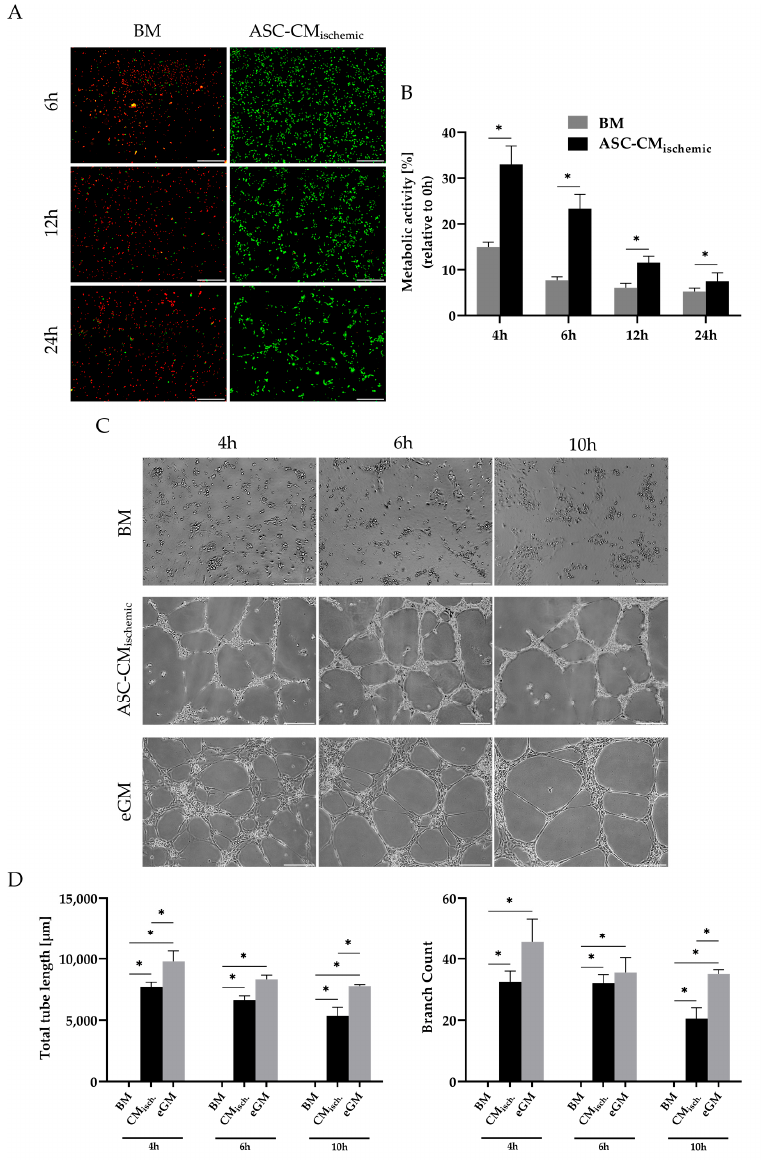
Figure 7. Effect of conditioned medium of glucose/oxygen-deprived ASCs (CM ischemic ) on viability and angiogenesis of human umbilical vein endothelial cells (HUVECs). ( A ) Live/dead staining at different time points. Viable cells were stained with calcein (green) and dead cells were stained with ethidium bromide (red) at different time points. Scale bar represents 500 μ m. ( B ) Determination of metabolic activity by a MTT assay; % metabolic activity was calculated in relation to the mean value of day 0. ( C ) Tube formation by HUVECs in basal medium, ASC-CM ischemic and endothelial growth medium on growth factor-reduced matrigel. Representative micrographs were shown at di ff erent time points (4, 6, and 10 h) for illustration of tube formation. Scale bar represents 200 µ m. ( D ) Total tube length (left column) and the number of branch points (right column) determined by an automated image analyzer. Data are presented as means ± SD of n = 3; * p < 0.05. Abbreviations: BM: Basal medium; eGM: Endothelial growth medium; ASC-CM ischemic : Adipose-derived stem cell-conditioned medium of glucose / oxygen-deprived